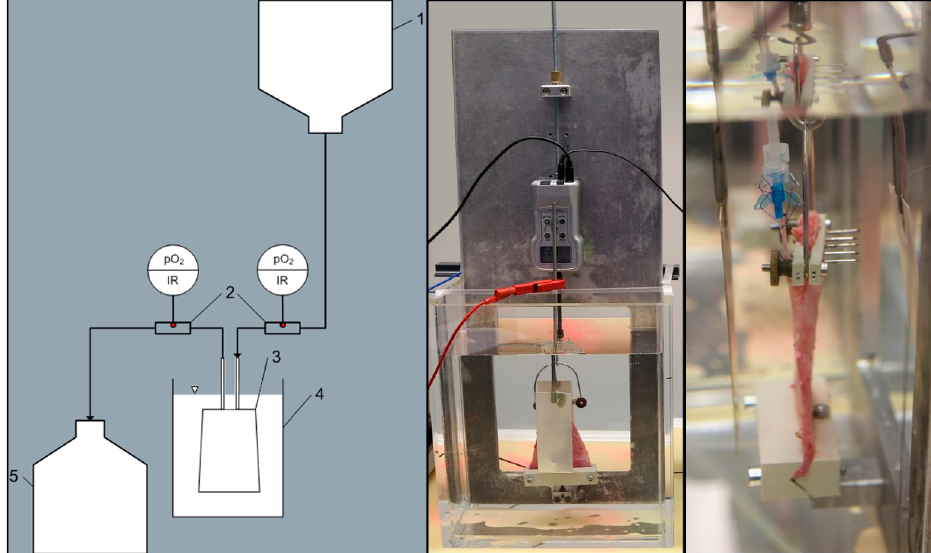
Figure 1. ( left ) Schematic representation of the experimental setup: reservoir bag (1), oxygen sensors (2), muscle flap (3) submerged in the reservoir (4), discarded perfusate (5). ( middle / right ) Pictures of the submerged muscle connected to a force gauge ( middle ) and the perfusate via cannulas ( right )